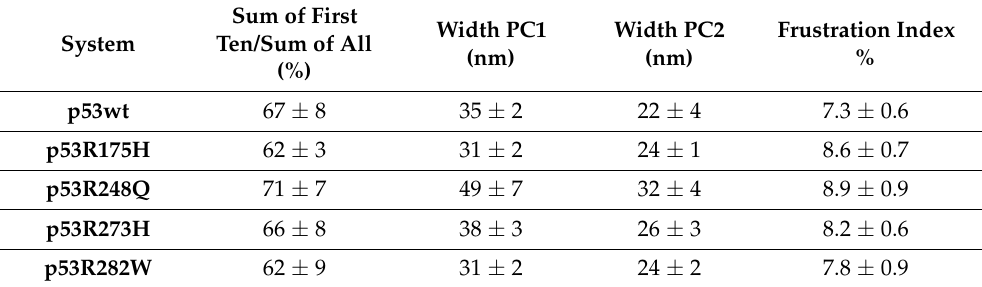
Table 2. ED and frustration properties of p53wt and of p53 mutants. ED parameters were derived from the 50–150 ns interval. Frustration index was evaluated from the average structure from the las 10 ns (141–150 ns).